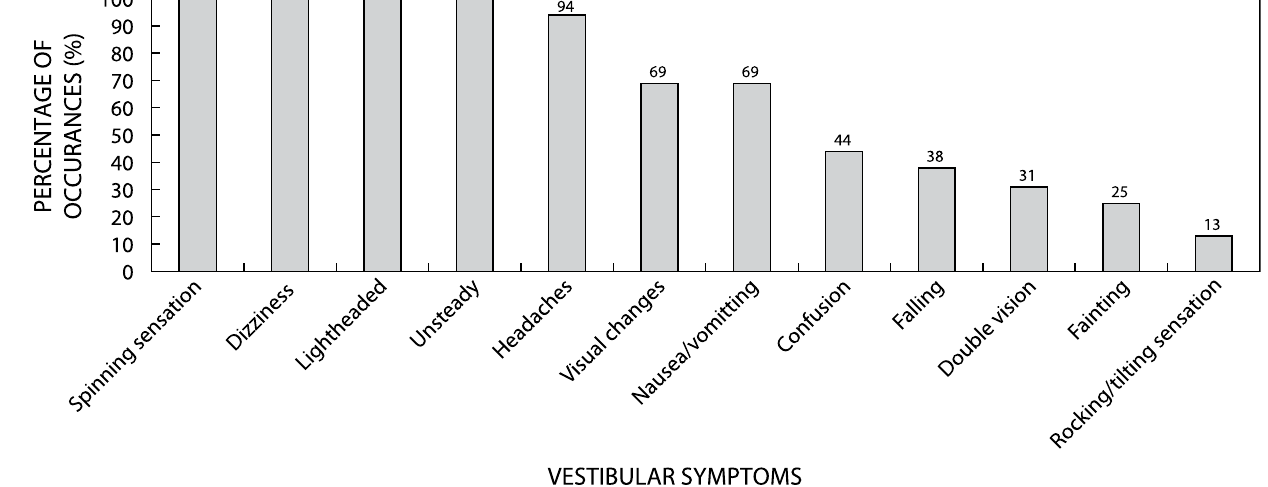
Figure 3: The occurrence of pathological vestibular symptoms ( N =